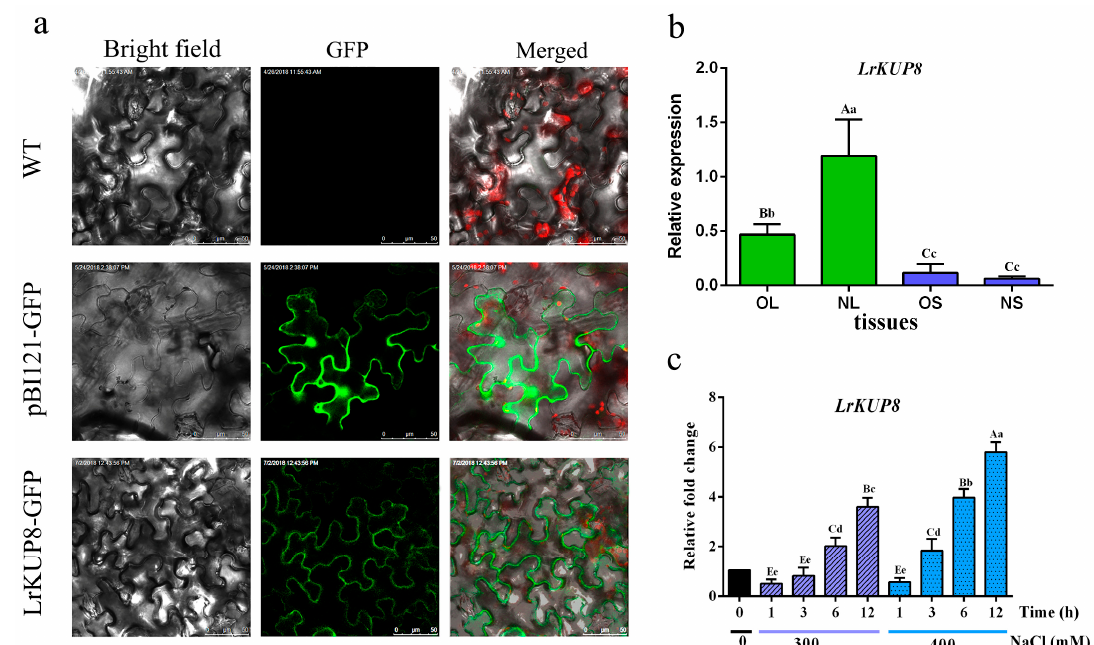
Figure 3. Cellular localization and expression patterns of LrKUP8 . ( a ) Tobacco epidermal cells were transiently transformed with constructs containing either control (GFP alone) or LrKUP8–GFP fusion plasmid. ( b ) Tissue expression level of LrKUP8. OL, NL, OS, and NS indicate old leaves, new leaves, old stems, and new stems, respectively. The relative expression of di ff erent developmental tissues was calculated by the 2 − ∆ CT method. ( c ) LrKUP8 expression levels in the calli under di ff erent saline conditions. The relative fold change data under di ff erent salt treatments were analyzed using the 2 − ∆∆ CT method. The upper- and lowercase letters on the histogram indicate p < 0.01 and p < 0.05, respectively. The mean ± SE of three replicates is